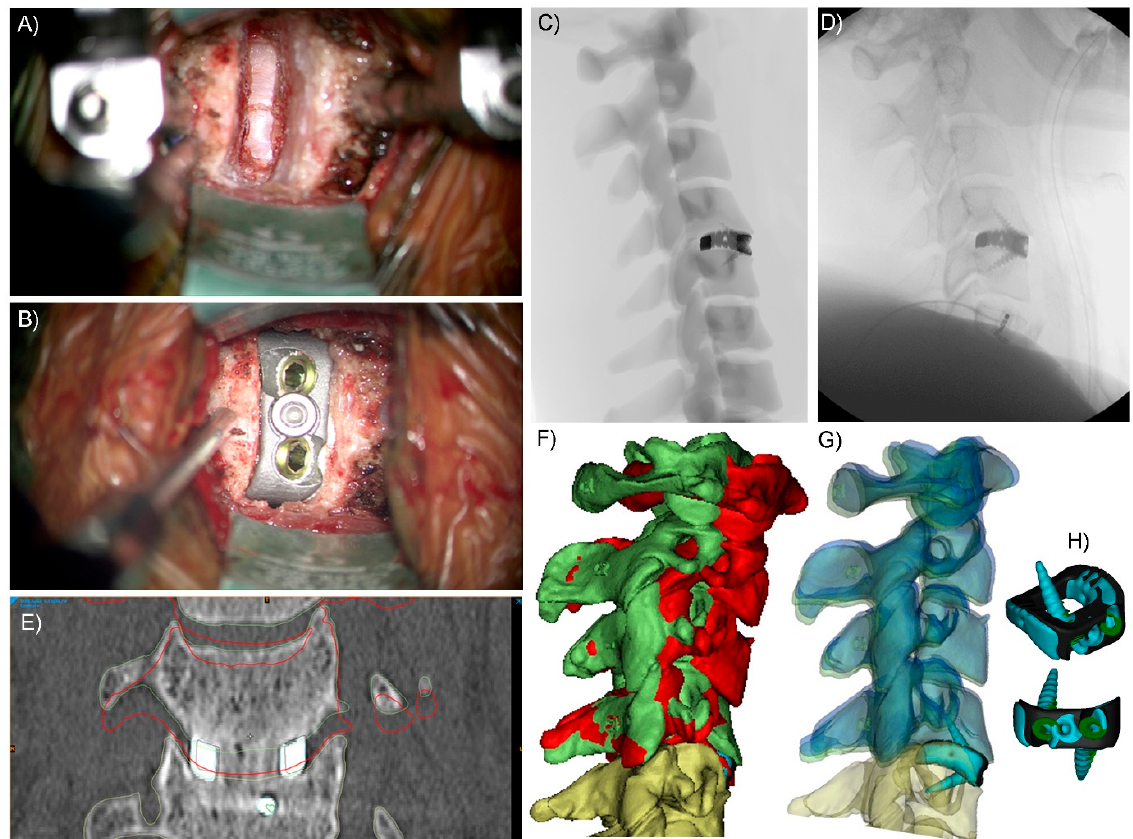
Figure 1. Stand-alone, integral screw fixation Anterior Cervical Discectomy and Fusion (ACDF) Patient-specific Implant (PSI) C4-5. ( A ) Surgical discectomy and preparation of the C4-5 interbody space ( B ) and surgical implantation of the integral screw fixation Titanium alloy PSI. ( C ) Simulated sagittal plane X-ray used intraoperatively to assess implant positioning (e.g., insertion depth), ( D ) actual intraoperative sagittal plane X-ray. ( E ) and three-month postoperative coronal plane CT slice showing fusion bone through the graft window of the Titanium PSI and no discernible subsidence. The red